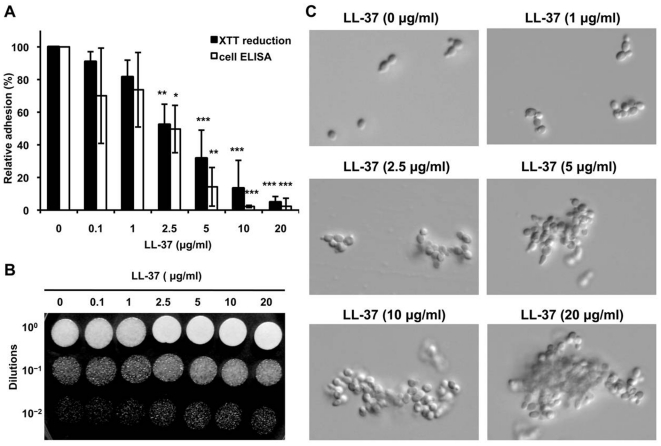
Inhibition of C. albicans adhesion by LL-37.(A) Cell adhesion to an abiotic surface (polystyrene). C. albicans cells were incubated in RPMI-1640 in polystyrene wells for 30 min and then washed three times with PBS to remove unattached cells. The attached cells were detected by measuring the reduction of XTT and by whole-cell ELISA using an antibody against C. albicans. All experiments were done in triplicate, and each was repeated three (XTT reduction assay) or four times (cell ELISA). The statistical significance for the number of treated vs. control cells was determined using Student's t-test (*, p<0.05; **, p<0.01; ***, p<0.001). (B) Spot assay to determine the number of viable, floating cells after LL-37 treatment. Different concentrations of LL-37 were incubated with cells in RPMI-1640 for 30 min; then the floating cells were collected, diluted onto YPD agar, and incubated at 30°C overnight. All experiments were done in triplicate, and each was repeated twice. (C) The morphology of the floating cells after LL-37 treatment was visualized by microscopy (400× magnification).